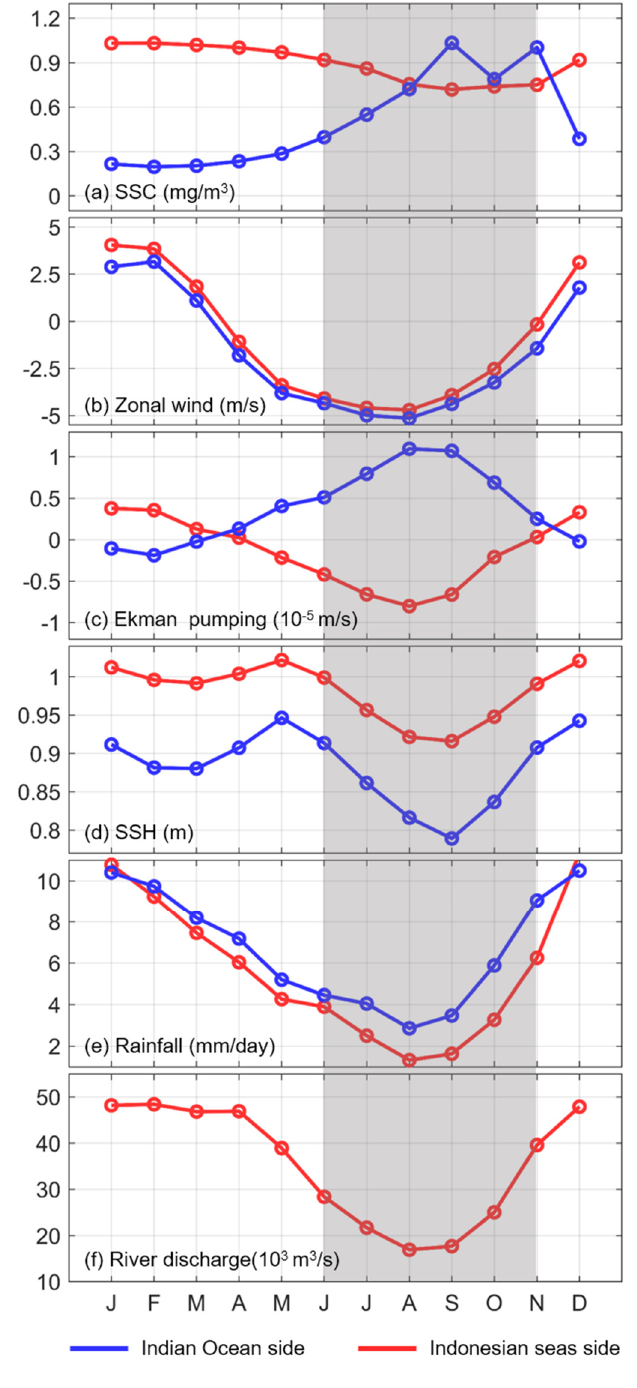
Figure 4. Climatological monthly mean variables during the period of 1998 to 2019. averaged over the areas of the Indian Ocean (area enclosed by blue lines area in Figure 1b) and Indonesian seas (area enclosed by red lines in Figure 1a) sides: ( a ) SSC; ( b ) sea surface zonal wind; ( c ) Ekman pumping; ( d ) SSH; ( e ) rainfall; ( f ) river discharge into the Indonesian seas. Note that only few small rivers empty into the Indian Ocean; therefore, they can be ignored. The gray-shaded area indicates the upwelling season.